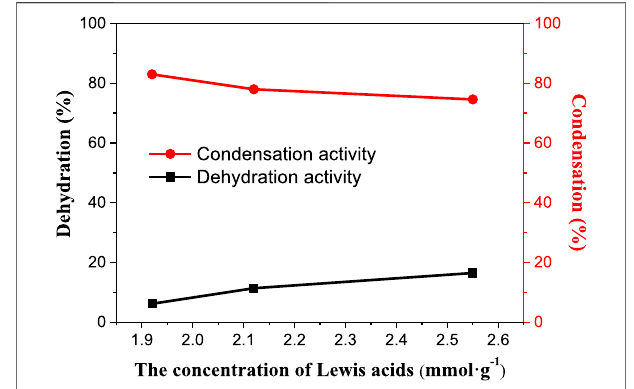
FIGURE 2 | The correlation between the concentration of Lewis acids and dehydration and condensation abilities of catalysts.